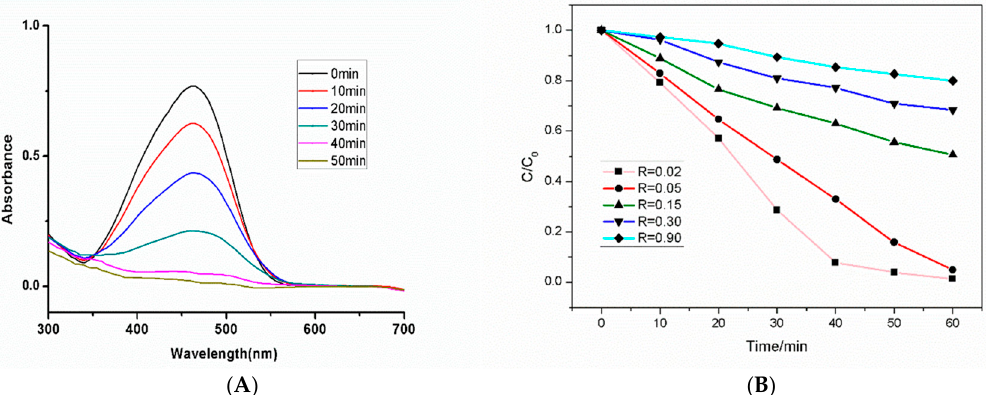
Figure 4. ( A ) Absorption spectra of the MO at different times with the assistance of the mace pods Ag@AgCl microcrystal (R = 0.02); ( B ) Comparison of degradation of MO by Ag@AgCl with hexapods with mace pods Ag@AgCl microcrystal (R = 0.02); ( B ) Comparison of degradation of di ff erent Ag MO by Ag@AgCl with different Ag content.